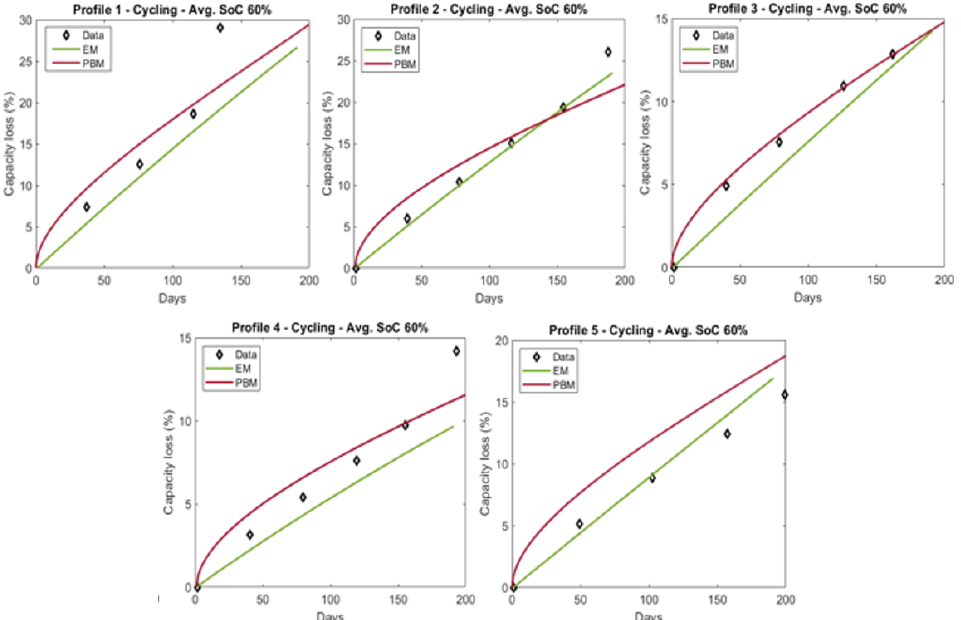
Figure 5. Comparison of capacity fade in cycling aging between aging data for the EM and PBM. The cycling conditions are identified by the profile number in Figure